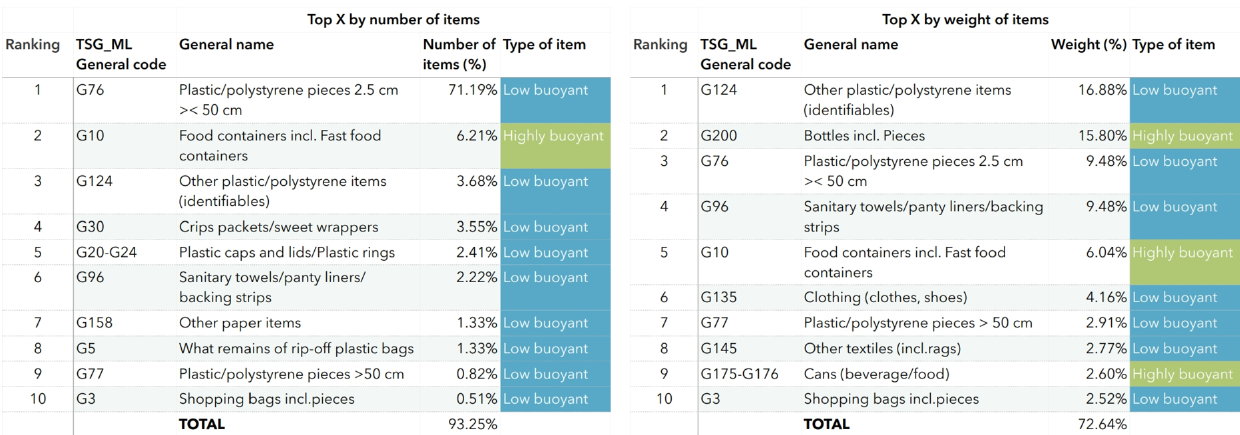
Figure 3. Composition of riverine litter by type of material in terms of the number of items and weight. Items were collected by the barrier placed in the Deba River (Gipuzkoa) between April and June 2018. Table 3. Top 10 (X) riverine litter items collected from the barrier located in the Deba River (Gipuzkoa) between April and June 2018. Items have been ranked by abundance (left) and weight (right) according to the master list categories of beach litter items and classified based on their exposure to the wind